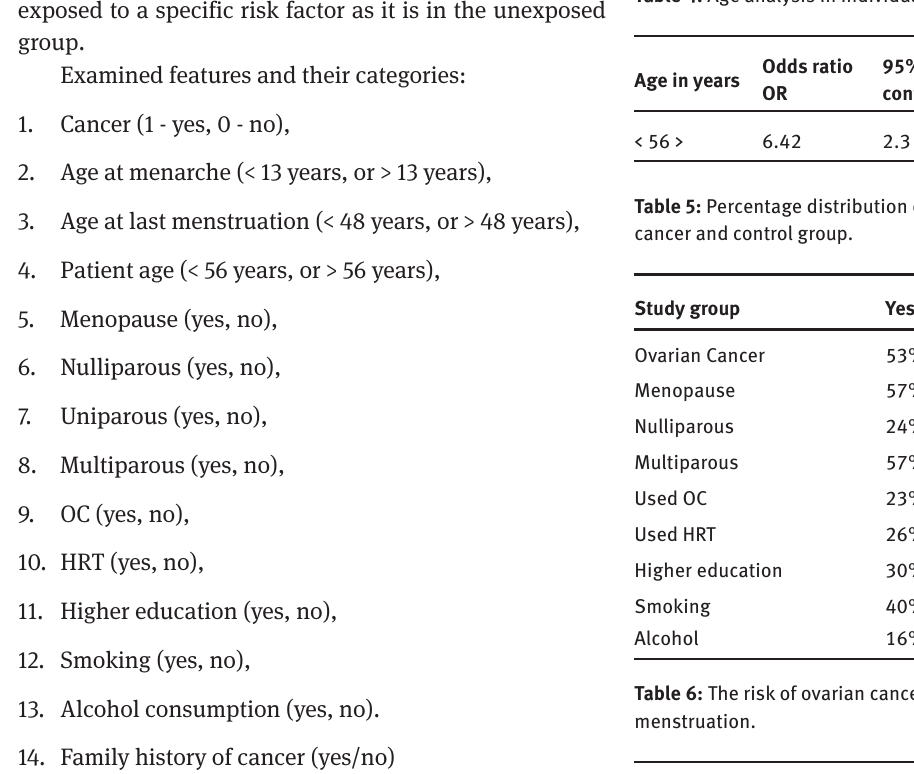
Table 4: Age analysis in individual groups